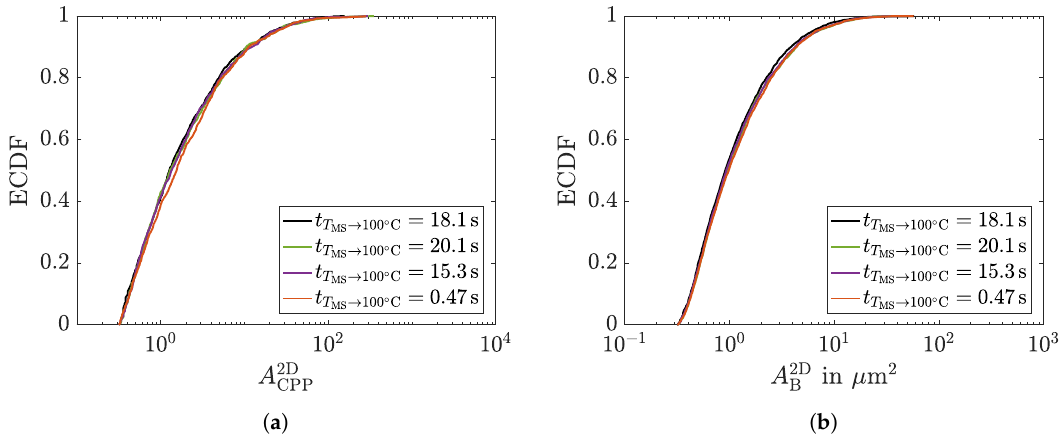
Figure 7. Empirical cumulative distribution function: ( a ) normalized packet cross section areas, ( b ) normalized block cross section